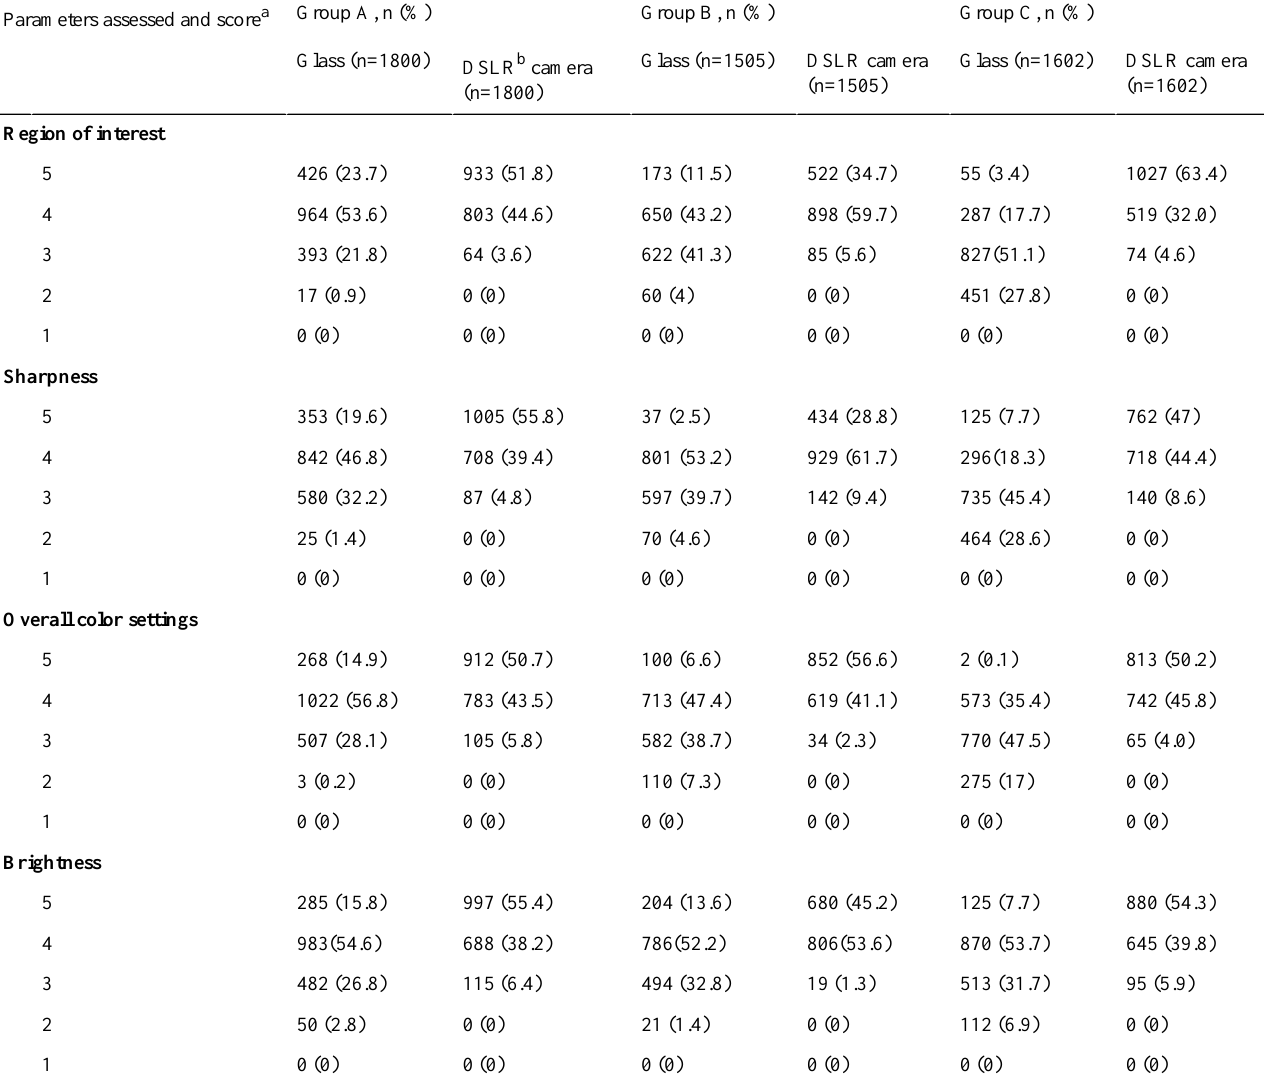
Table 2. Frequencies and percentages of evaluations given by 5 pathologists for images taken during forensic necropsies with Google Glass and Nikon D3200 reflex camera stratified for each